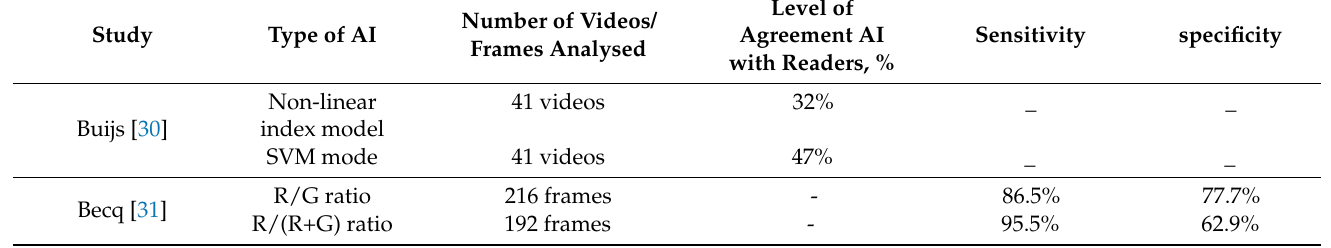
Table A2. Summary of the two studies on AI assessment of CCE bowel cleanliness.